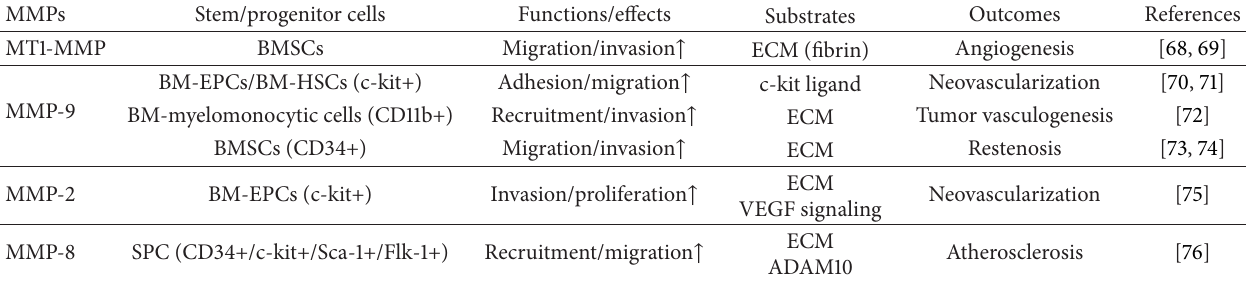
Table 1: MMPs, stem/progenitor cell mobilization and recruitment, and